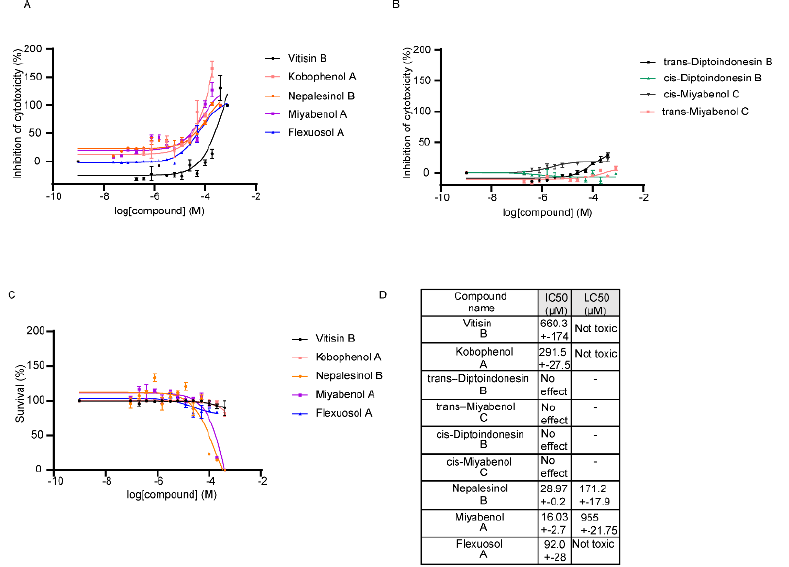
Figure 1. Ex vivo assays for the first pharmacological screening of the compounds. ( A ) Compounds that showed potential to downregulate the TNF induced cytotoxicity on L929 cells. ( B ) Compounds that were ineffective in downregulating the TNF induced cytotoxicity on L929 cells were excluded from further analysis. ( C ) Cytotoxicity of the effective compounds on L929 cells. All error bars indicate SEM values. ( D ) Conclusive table of the IC50 values of A and LC50 values of ( C ).